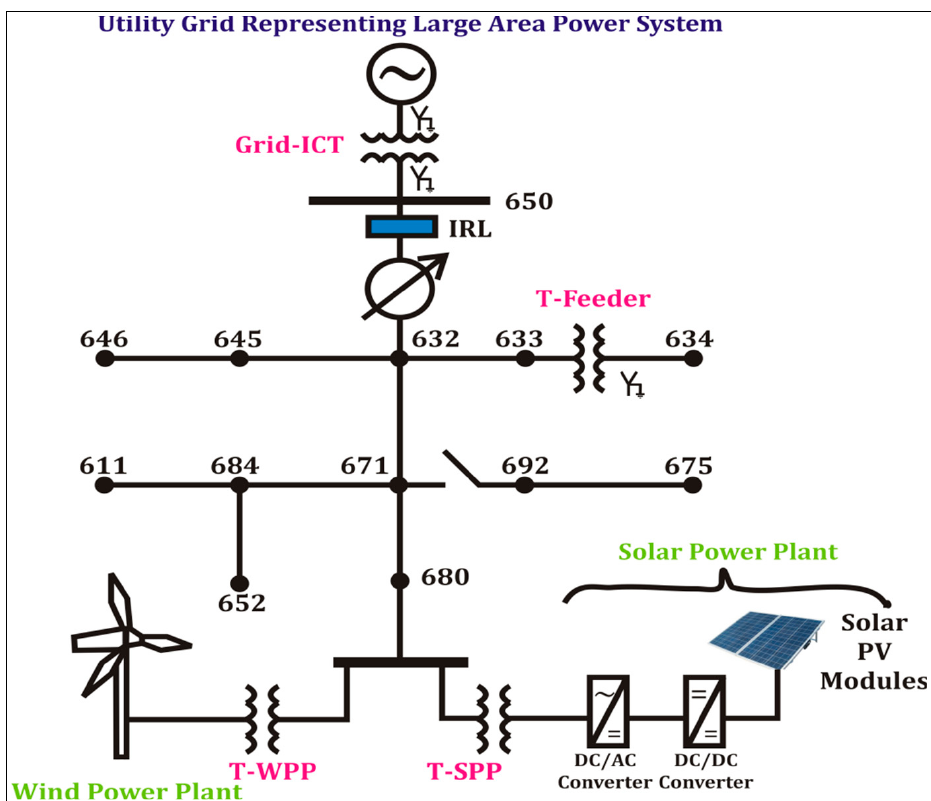
116 680 650 Table 2. Data of transformer of test system.